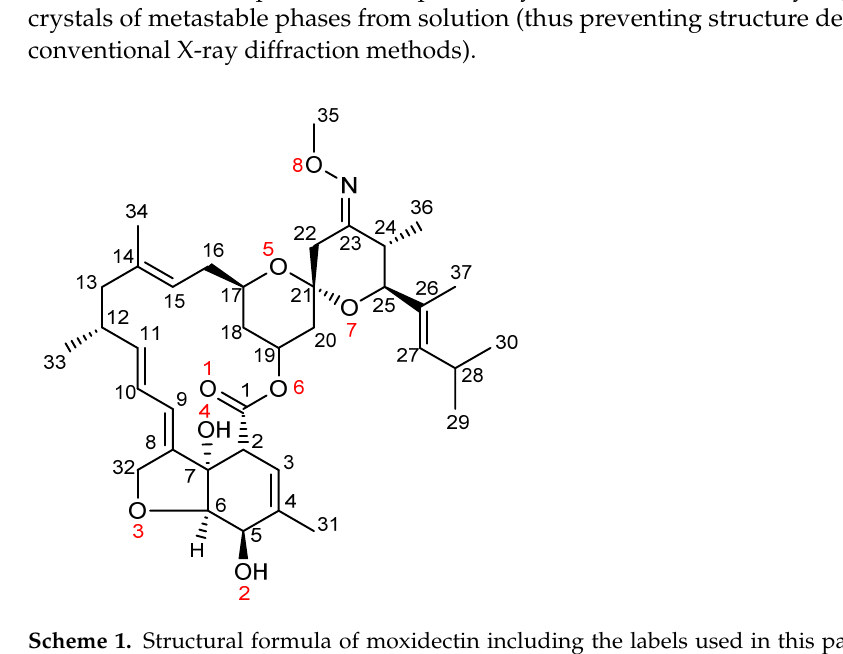
Scheme 1. Structural formula of moxidectin including the labels used in this paper for SC-XRD structure description (numbers in black for carbon and red for oxygen atoms). Table 1. Synoptic collection of moxidectin crystal forms as well as structural data and literature